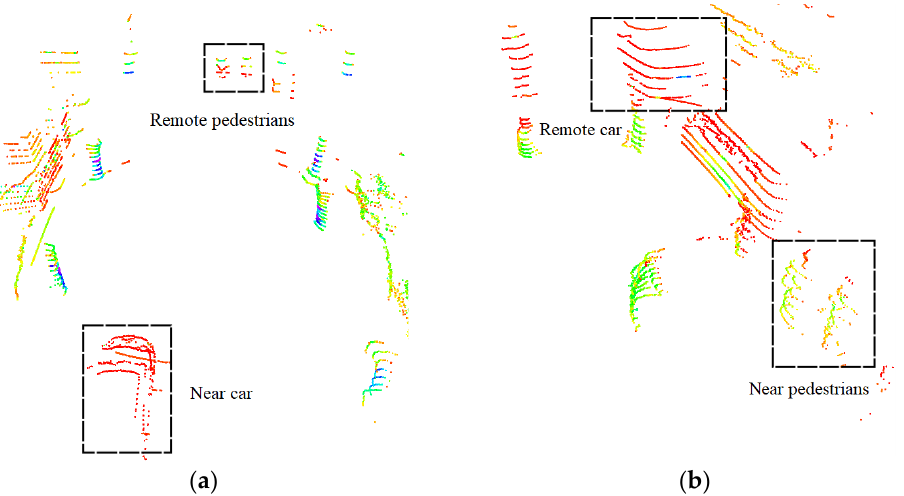
Figure 8. Point clouds of pedestrians and cars: ( a ) the point cloud of the pedestrians is remote, and the point cloud of the car is near; ( b ) the point cloud of the pedestrians is near, and the point cloud of the car is remote.